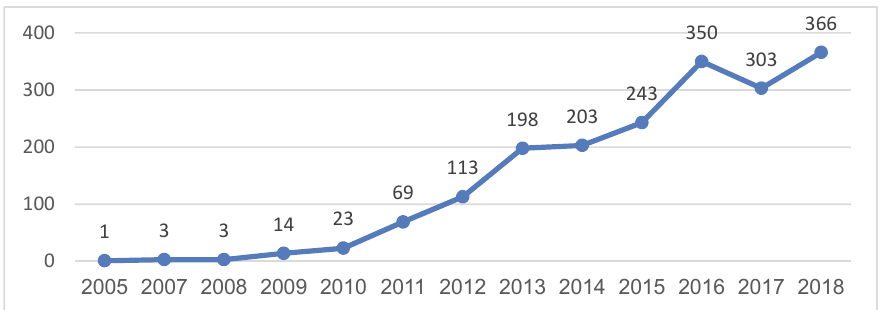
Fig. 1. The Scopus publications on the analysis of social media and e-commerce from 2005 to